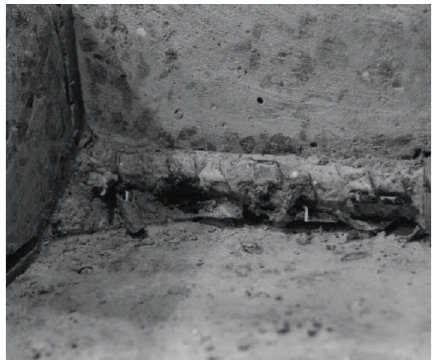
Figure 4: Steel-concrete interface for the GPC beam.